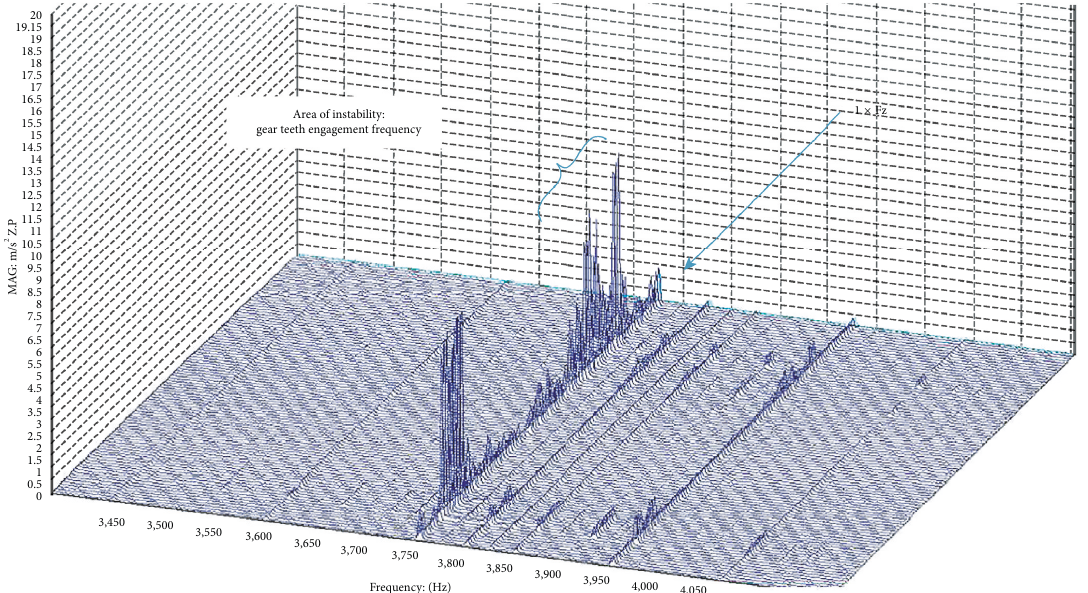
Figure 4: Dynamic signal area in the high-frequency acceleration range up to 20